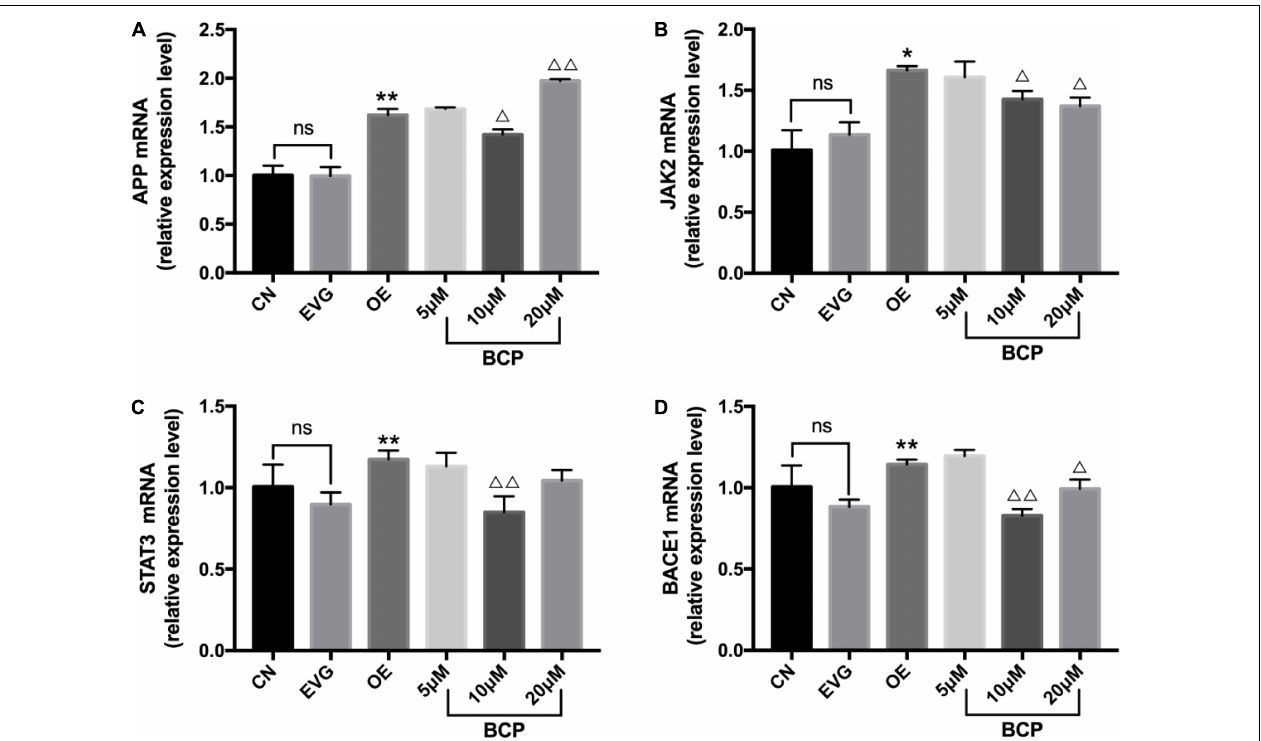
FIGURE 4 | Expressions of JAK2, APP, STAT3, and BACE1 mRNA in the PC-12 cells. CN denotes the control group without special treatment; EVG denotes the empty vector group in which the PC-12 cells were transfected with plasmid vectors without gene fragments; OE denotes the group in which the PC-12 cells were transfected with a plasmid containing APP cDNA; and BCP denotes the group in which the effect of BCP was assessed on 24-h viability of PC-12 cells transfected for 48 h. (A) Relative expression level of APP mRNA. (B) Relative expression level of JAK2 mRNA. (C) Relative expression level of STAT3 mRNA. (D) Relative expression level of BACE1 mRNA. Compared with CN, ns p > 0.05. Compared with EVG, * p < 0.05, ** p < 0.01. Compared with OE group, (cid:49) p < 0.05, (cid:49)(cid:49) p < 0.01. One-way ANOVA with Bonferroni’s post hoc test.